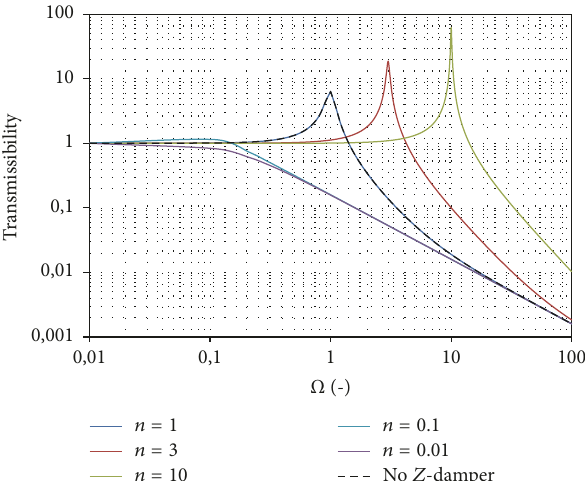
Figure 4: Transmissibility module versus frequency ratio for the 𝑍 - damper stiffness configuration. Damping ratio 𝜉 = 0.1.